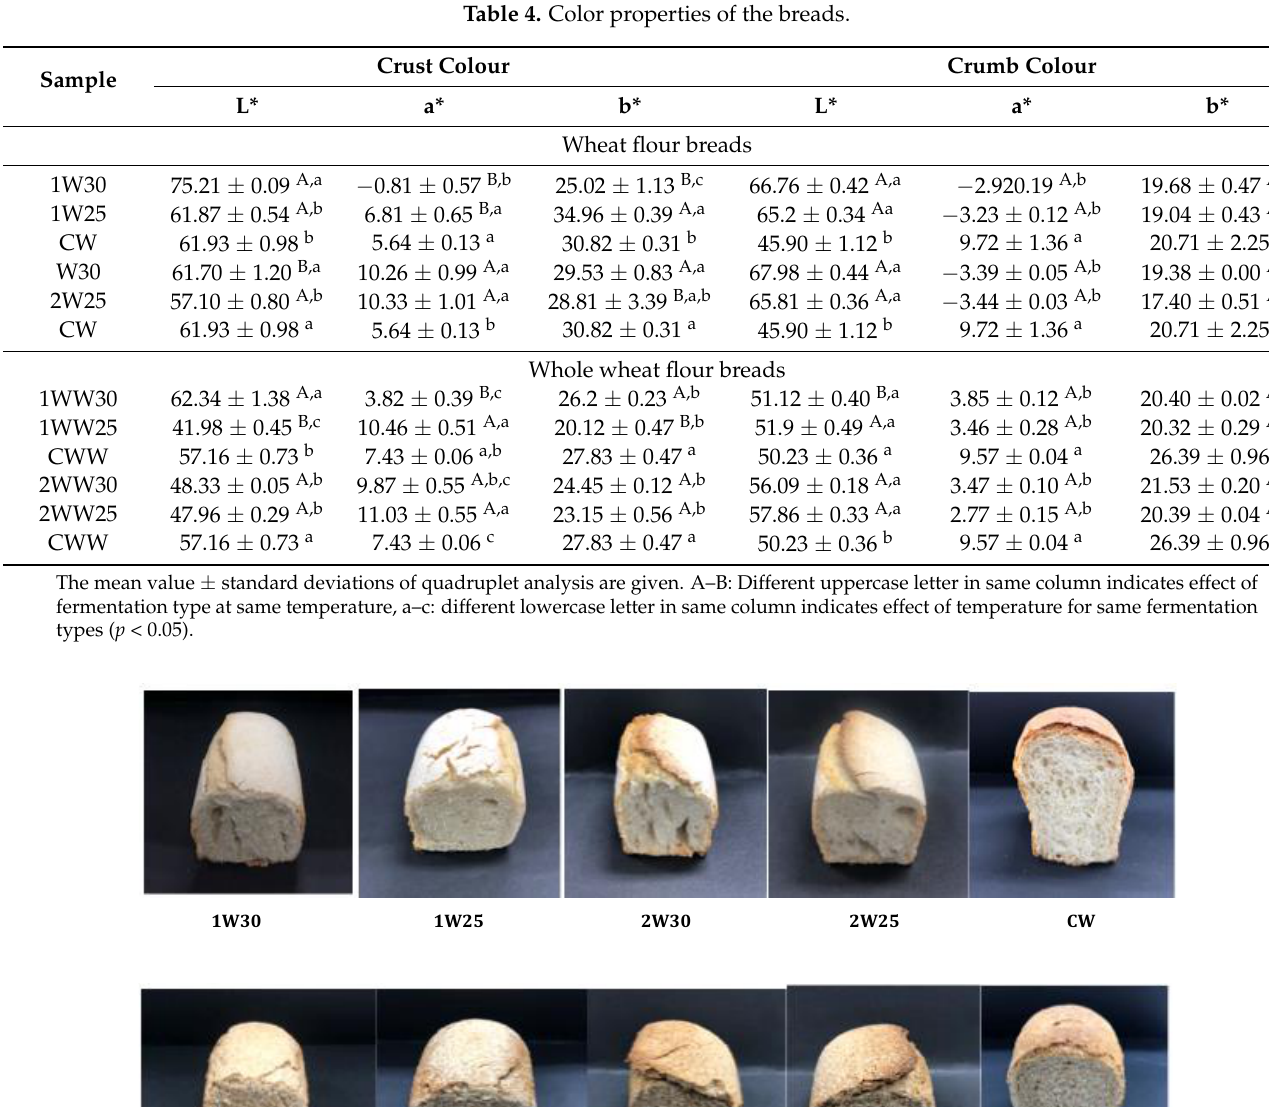
Table 5. Chemical composition of samples.